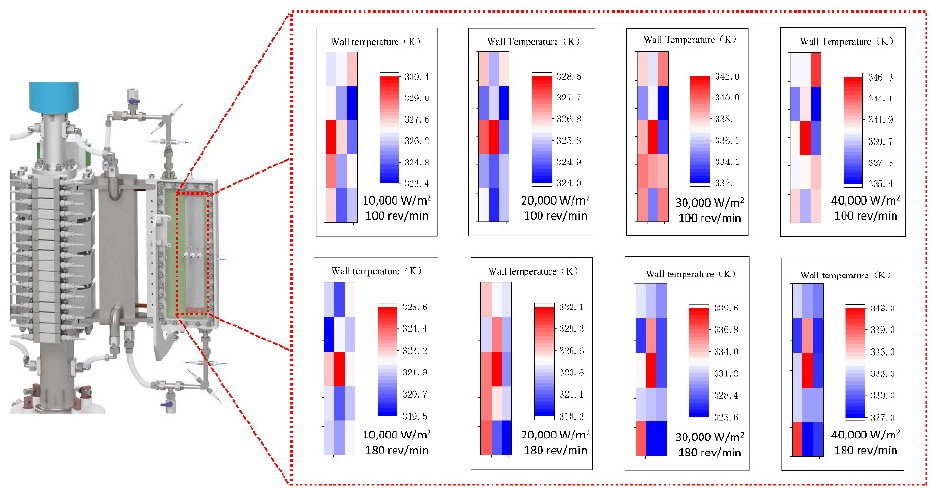
Figure 7. Comparison of wall temperature